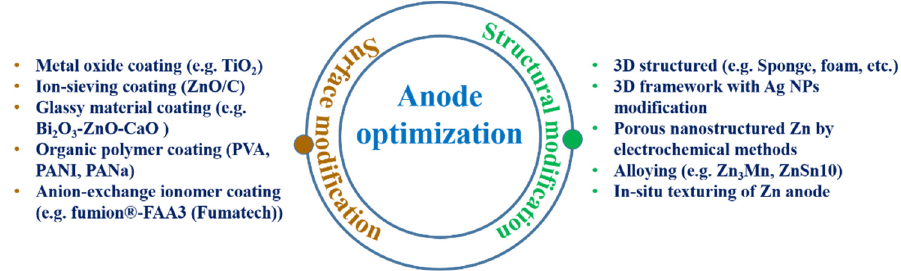
Figure 12. Schematic of anode optimization techniques. Table 1. Summary of research articles focused on zinc anodes optimization and a selection of their performance criteria (last five years).